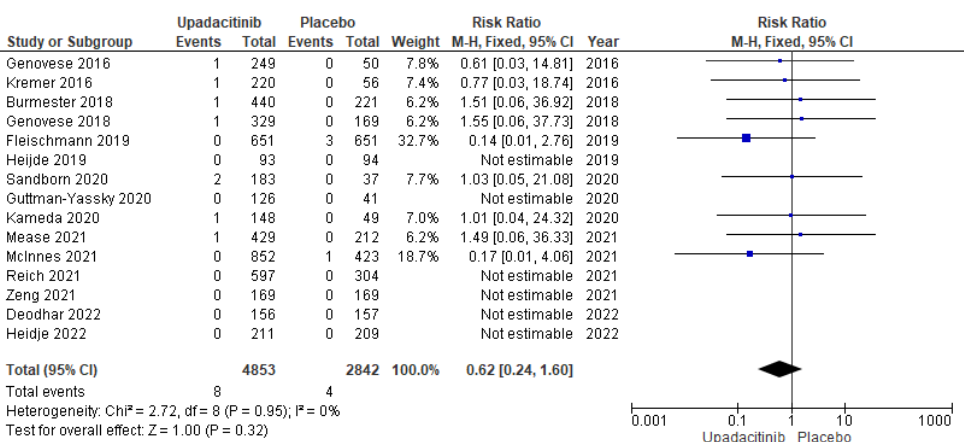
Figure 4. Forest plot of the comparison: upadacitinib vs. placebo. Outcome: major adverse cardio- vascular events [8 – 12,15 – 17,20 – 26].